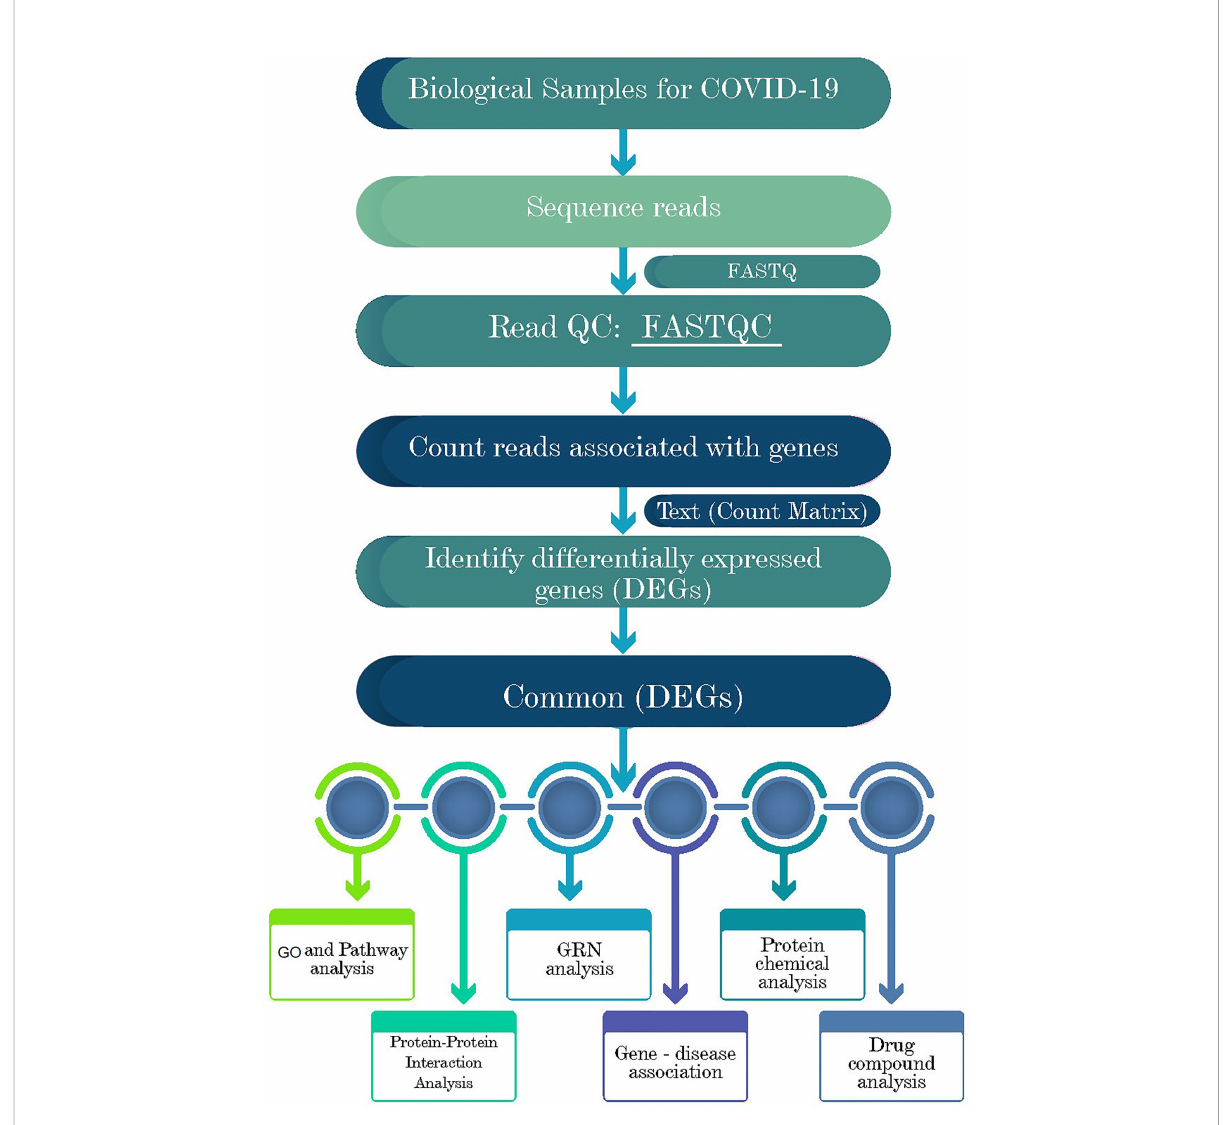
FIGURE 1 Schematic representations of the paths for differentially expressed genes (DEGs) analysis in RNA-seq data of the COVID-19 patients, recovered humans, and healthy controls nasopharyngeal